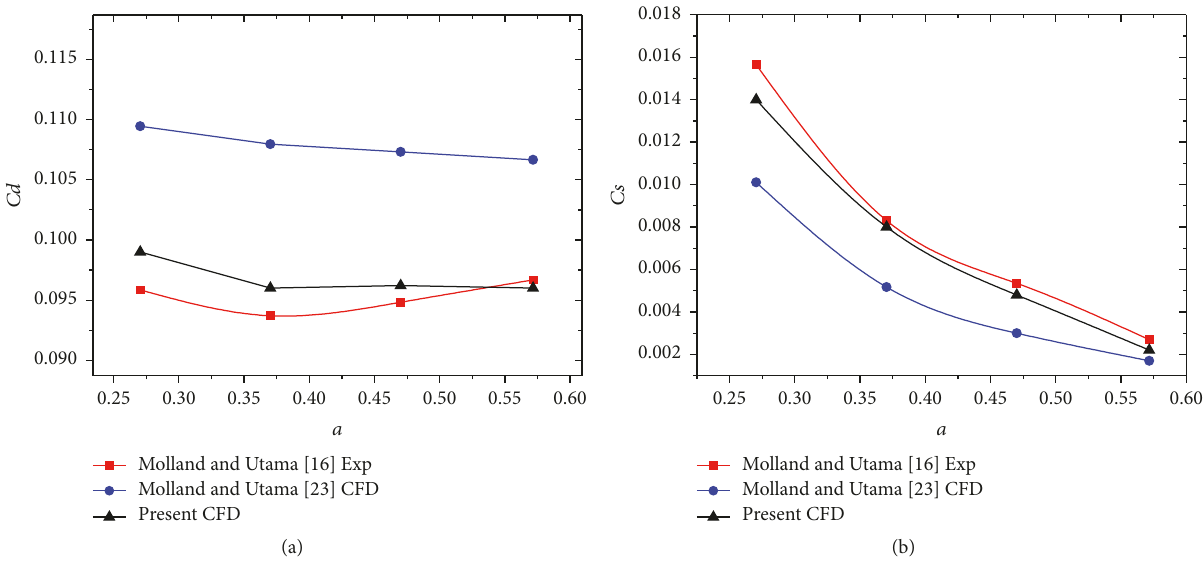
Figure 7: Results of the validation study: (a) coefficients of drag and (b) coefficients of side force.